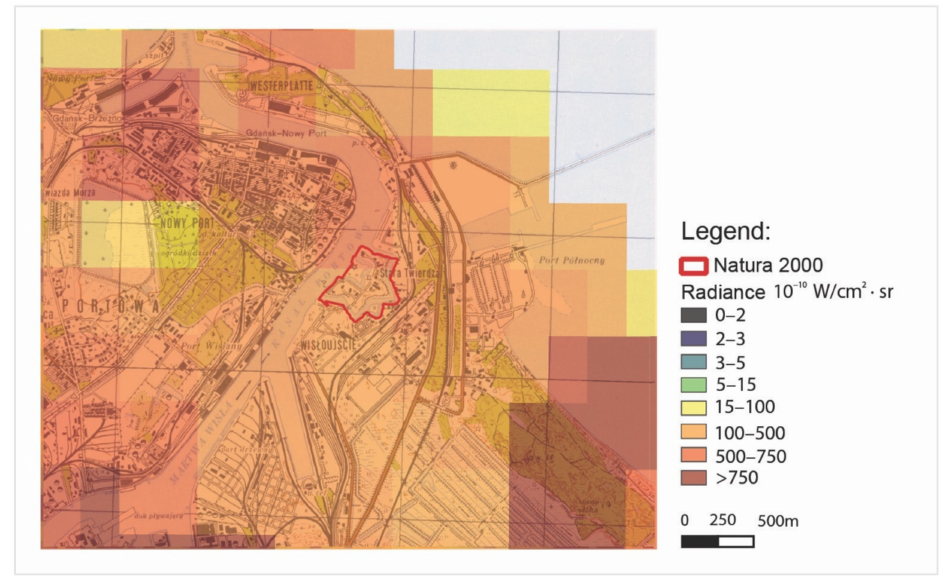
Figure 16. Radiance map taken on 28 August 2020 showing a close-up of the Natura 2000 Wisłouj´scie Fortress. The grey colour of pixels represents the lowest radiance levels between 0 and 0.2 nW/cm 2 · sr = 0–2 10 − 10 W/cm 2 · sr, while the red colour represents the highest, bright- est radiance levels of >75 nW/cm 2 · sr = >750 10 − 10 W/cm 2 ·